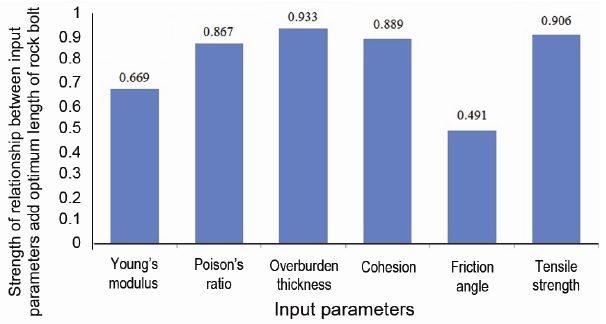
Fig. 6. Strength of the relationship between input parameters and the optimal length of a